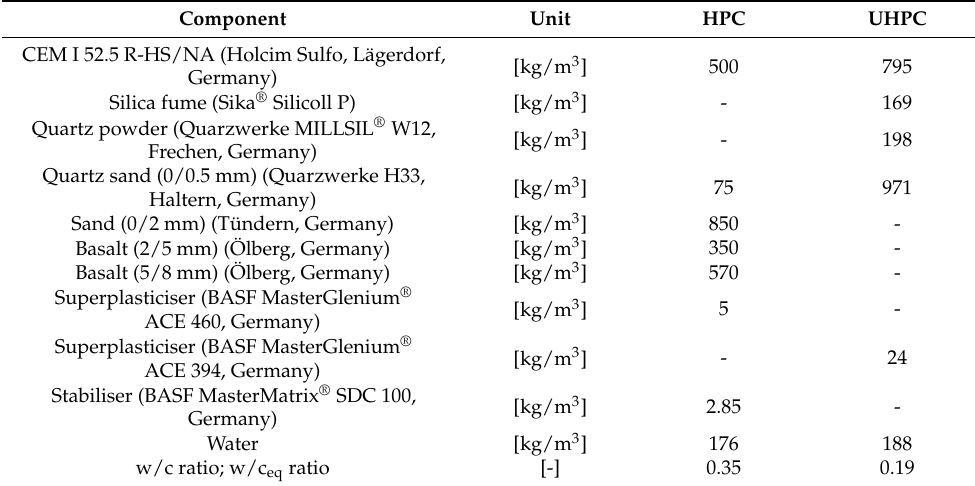
Table 1. Compositions of